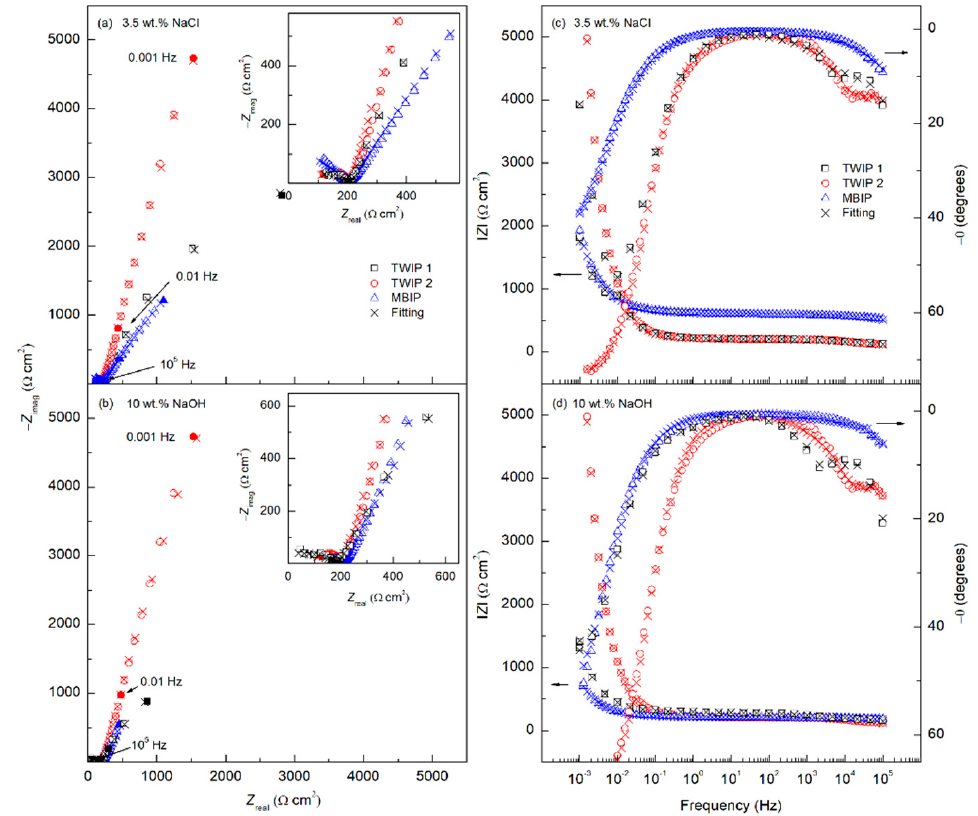
Figure 20. Nyquist plots of two TWIP steels (Fe − 22.6Mn − 6.3Al − 3.1Cr − 0.68C and Fe − 28Mn − 5.2Al − 5.1Cr − 2.8Si − 0.95C) and a MBIP steel (Fe − 30Mn − 8.5Al − 3.2Cr − 1.1Mo − 1.0C) in: ( a ) 3.5 wt.% NaCl solution, and ( b ) 10 wt.% NaOH solution. Corresponding bode plots in: ( c ) 3.5 wt.% NaCl solution, and ( d ) 10 wt.% NaOH solution